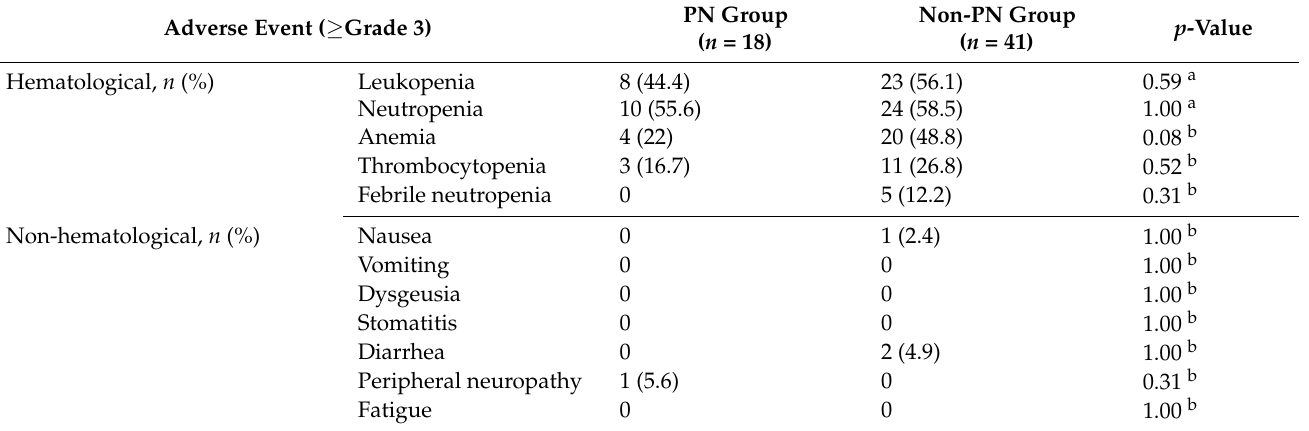
Table 4. Comparison of the incidence of adverse events ( ≥ Grade 3) between the PN and non-PN